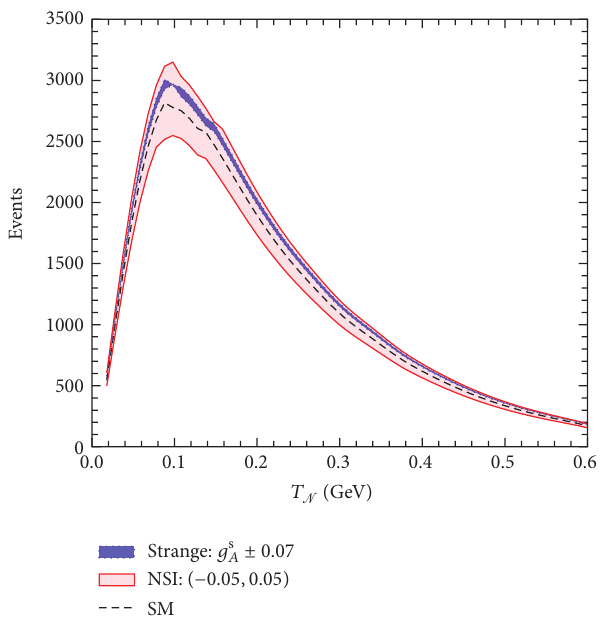
Figure 9: Allowed region in the (𝜖 𝑢𝑉 𝜇𝑒 −Δ𝑠) plane at MiniBooNE. The best fit point is shown by ⋆